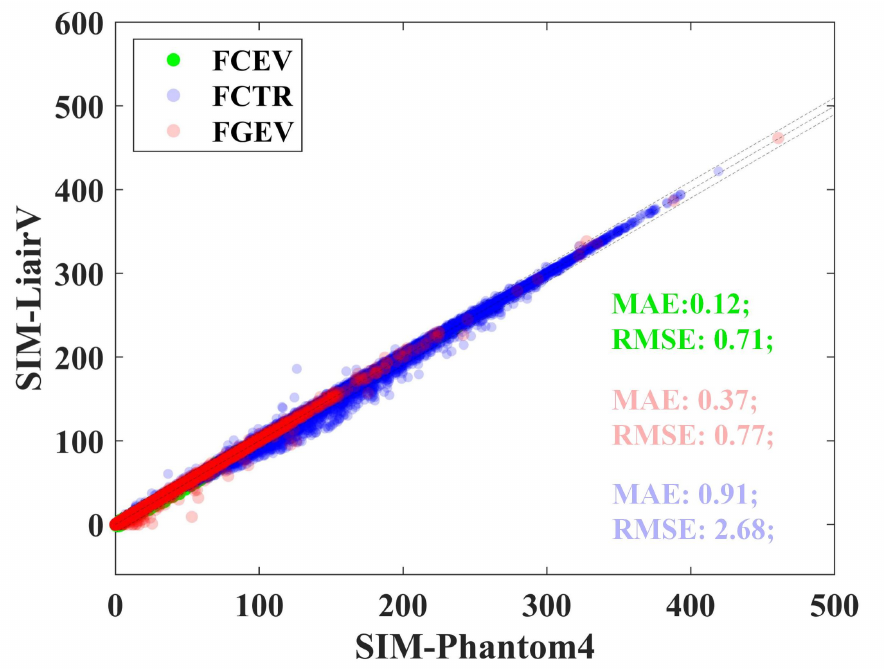
Figure 9. Comparison of the LH components under the LPR and VPR scenarios. The green font represents LH g , v , the pink font represents LH g , b , and the blue font represents LH v